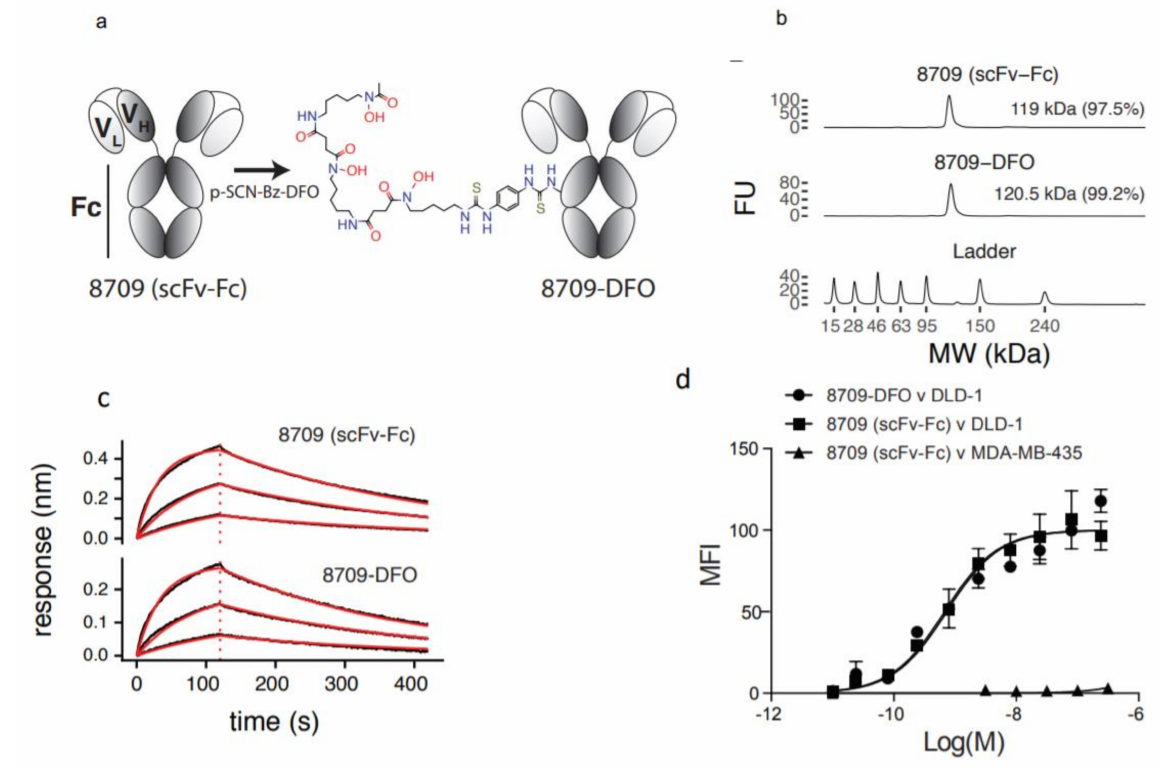
Figure 1. Characterization of DFO-8709-scFv-Fc. ( a ) Conjugation of 8709-scFv-Fc to DFO, ( b ) Bioanalyzer analysis for 8709- scFv-Fc and 8709-scFv-Fc-DFO, Bioanalyzer shows ladder (L), 8709-scFv-Fc, DFO-8709-scFv-Fc ( c ) biolayer interferometry (BLI) ( d ) Flow cytometry analysis of 8709-scFv-Fc and DFO-8709-scFv-Fc in EGFR positive DLD-1 and EGFR negative MDA-MB-435 cell